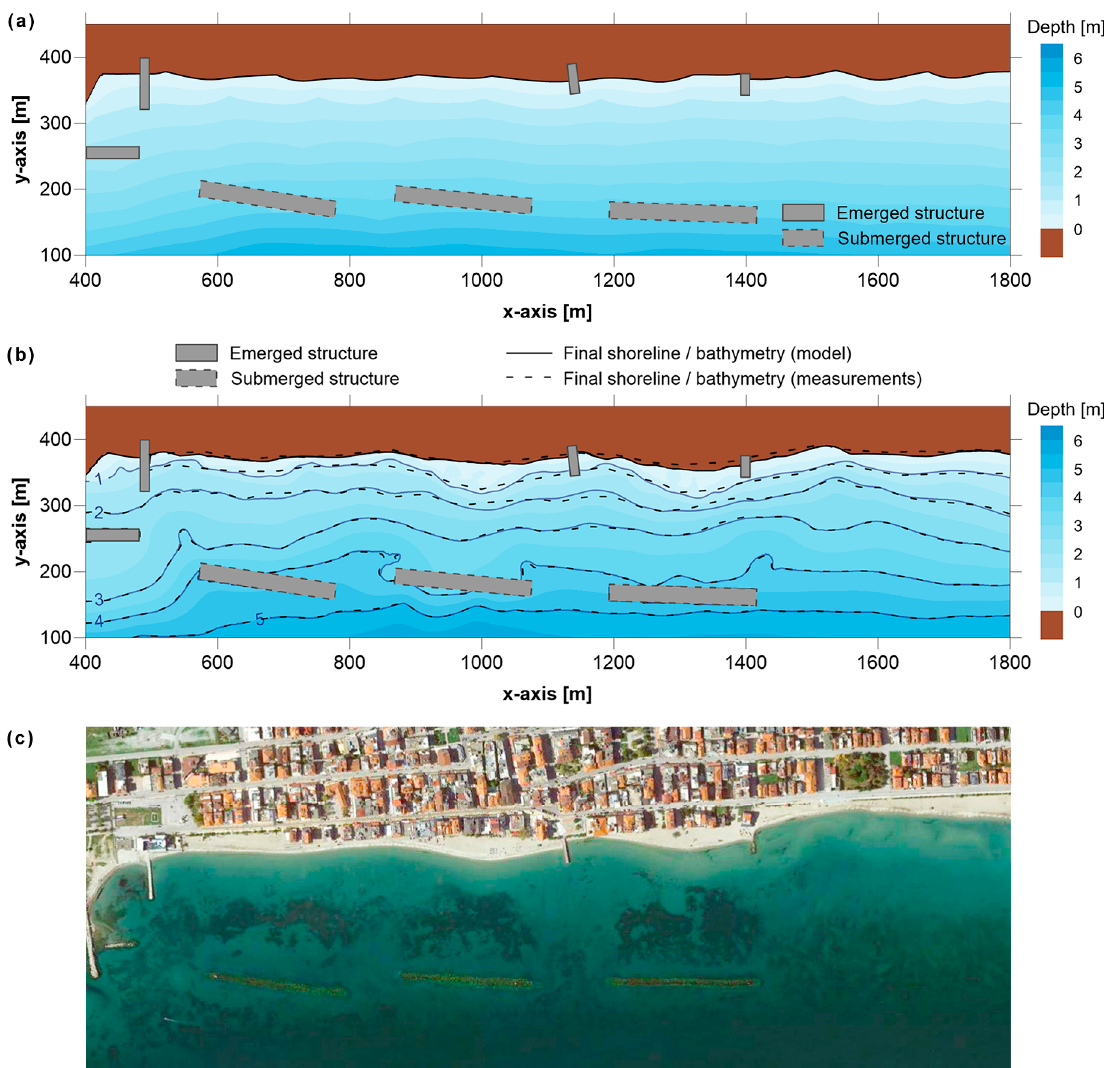
Figure 6. ( a ) Initial bed morphology of Paralia Katerinis beach, ( b ) comparison between the computed and measured bed morphology evolution, and ( c ) satellite image of the same area ([47]; privately processed).